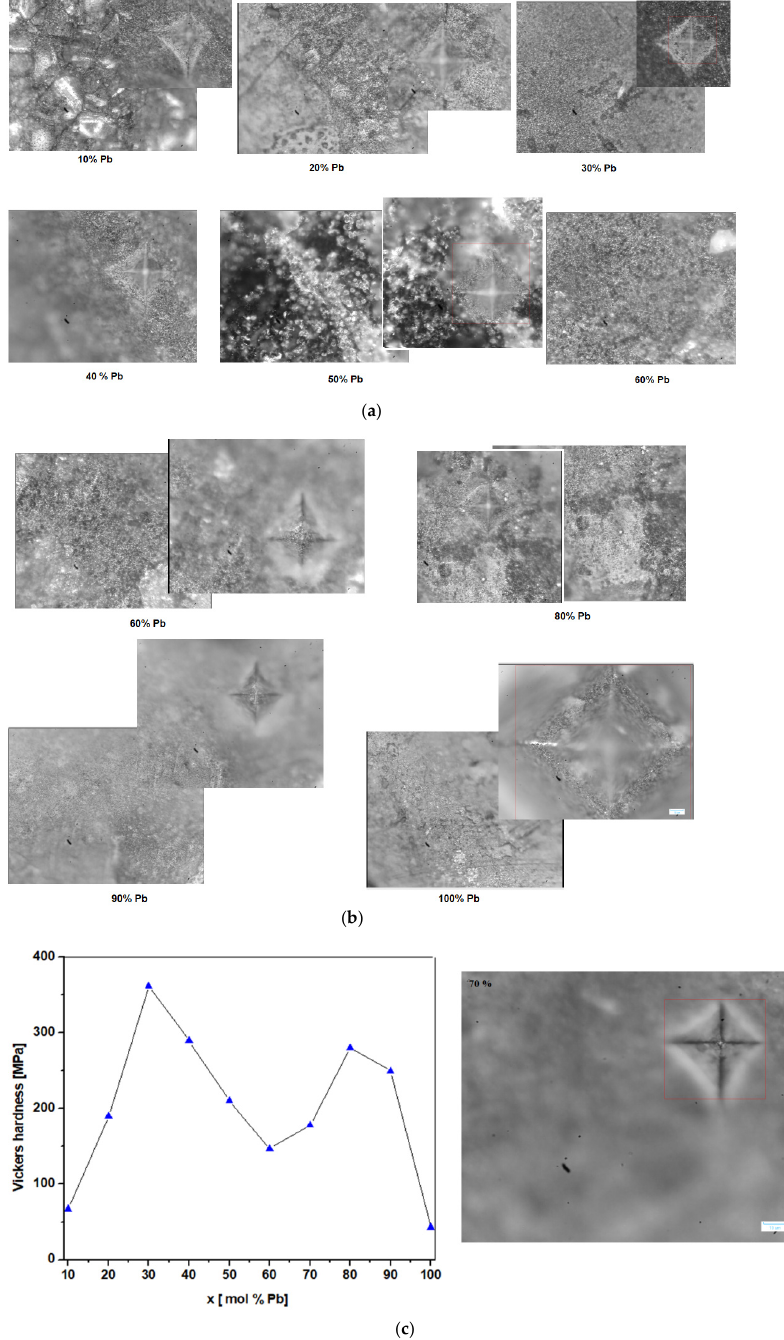
Figure 8. ( a , b ) Microscopic images and traces with the pyramidal contour obtained after indentation (the caption with red square represents measured area in the four points) for the vitroceramic sys ‐ tem with chemical formula of 15MnO 2 ∙ 85[(100 − x)PbO 2 ∙ xPb] where x = 0–100 mol% Pb. ( c ) Compo ‐ sitional dependence of Vickers hardness, HV, for the vitroceramic system with chemical formula of 15MnO 2 ∙ 85[(100 − x)PbO 2 ∙ xPb] where x = 0–100 mol% Pb for a force of 0.3 kgf, applied for 15 s. The graphical representation of the Vickers hardness values according to the sample composition are highlighted in Figure 8b. By comparing the values of Vickers hardness for the studied electrode materials, it was found out that their values increase up to x = 30 mol% Pb, decrease linearly for 40 ≤ x ≤ 60 mol% Pb, then pass again through a maximum for the vitroceramic with x = 80 mol% Pb, after which they decrease again for contents higher than 90 mol% Pb. The smallest values of the Vickers hardness are found in the samples with x = 10 (HV = 67.2 MPa) and 100 mol% Pb (HV = 42.8 MPa). The sample with x = 20 mol% Pb (HV = 190 MPa) has a slightly lower hardness than the one with x = 90 mol% Pb (HV = 250 MPa), although it has a higher lead content in the structure. The presence of cracks in a vi ‐ troceramic affects its mechanical properties, yielding a decrease of Vickers hardness. Our results show that the presence of micro ‐ and macro ‐ cracks in the studied mate ‐ rial produces a decline of the hardness values. The wear process of the electrode vi ‐ troceramic is accentuated when the mechanical strength are reduced. The evolution of the mechanical performances can be associated with the water bounded to material components [17] and with ion mobility, respectively [18]. In the cyclic voltammetry, the presence of the anodic wave situated at about +1.23 V can be correlated with the presence of the water at surface, after the redox reaction: 2H 2 O ↔ O 2 + 4 H + + 4e − For samples with 30 and 80 mol% Pb, the wave is more present while for the samples with x = 10, 40, 50, 60, 70, 90, and 100 mol% Pb, the wave disappeared. The presence of water at the surface can be explained considering that the material components are mobile in the vitroceramics with x = 30 and 80 mol% Pb and result in an increase of the Vickers hardness value. For vitroceramics with x = 10, 60, and 100 mol% Pb, the smaller values of the Vickers hardness can be associated with the rigidity of the components in the host matrix. The sample with x = 90 mol% Pb has the lowest value of the formal potential which suggests a good reversibility of cyclic voltammogram (according to Table 2). In addition, the higher value of the current density intensity (Table 2) and Vickers hardness (Figure